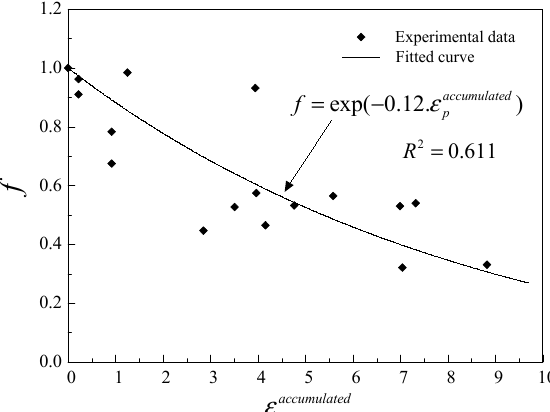
Materials 2019 , 12 , x FOR PEER REVIEW Figure 9. Scatter plot and fitted curve of damage degradation parameter for Q345qC.